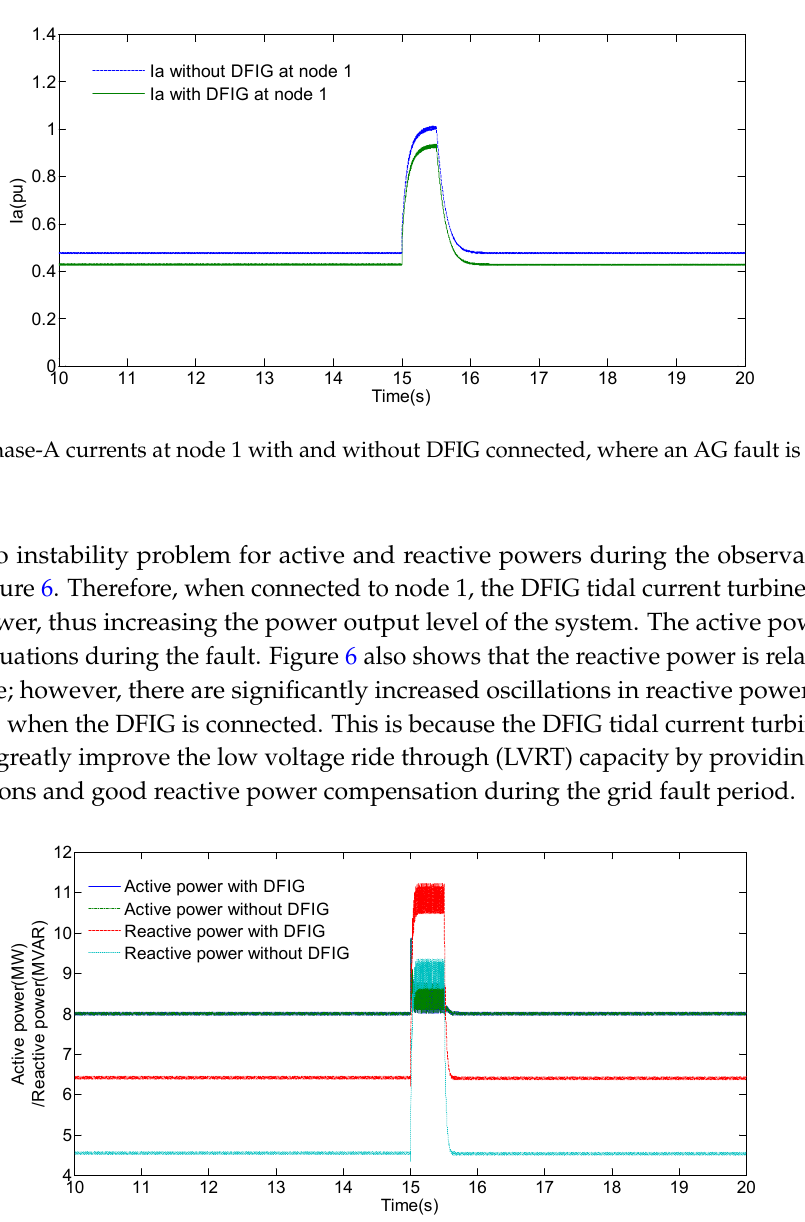
Figure 6. Active and reactive powers at node 1 with and without DFIG connected, where the active power with DFIG is in the same level as the active power without DFIG.